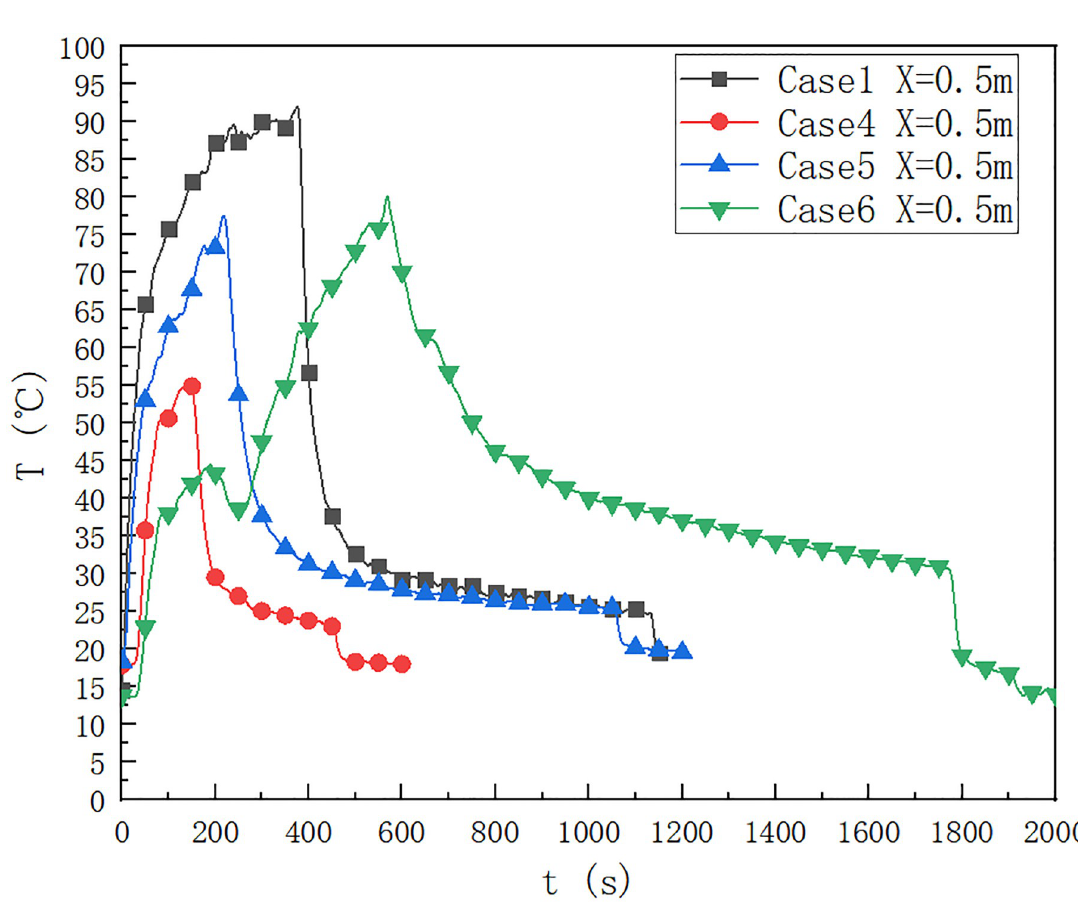
Fig 6. Temperature change below the ceiling of the cable compartment in the utility tunnel at 1, 4, 5 and 6 at a distance of 0.5 m from the fire source.